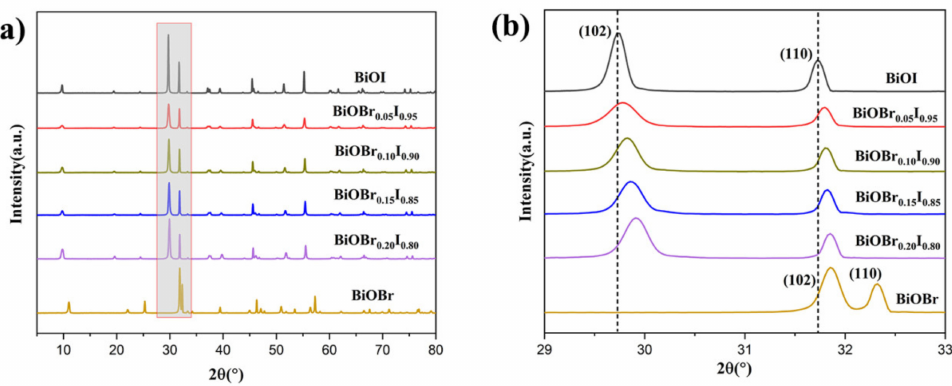
Figure 1. ( a ) XRD patterns of BiOBr X I 1 − X samples (x = 0.00, 0.05, 0.10, 0.15, 0.20, 1.00). ( b ) The magnified portion of the patterns with 2 θ ranging from 28.9 to 33.2 ◦